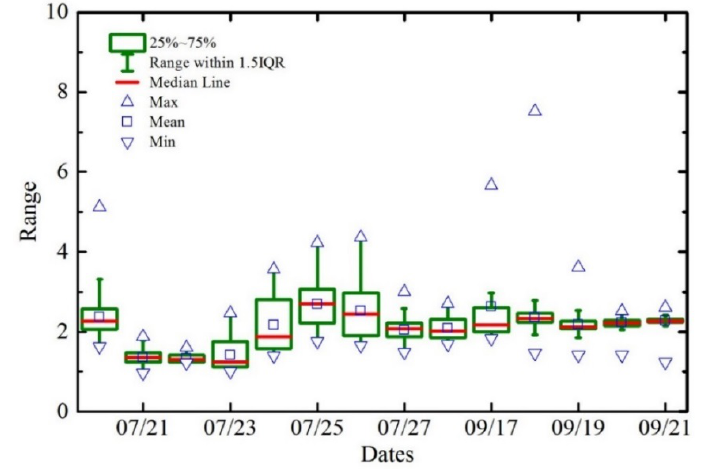
Figure 10. Boxplots representing the intra- and inter-diurnal variations of Chl-a at site A and B.